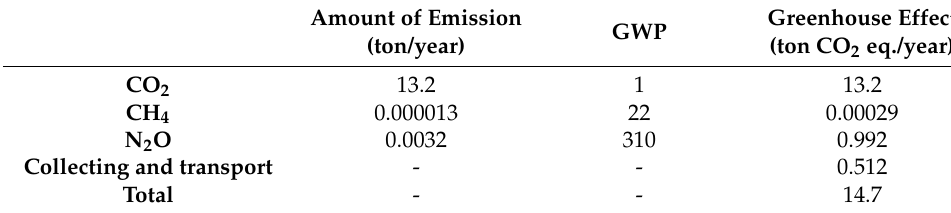
Table 16. The total amount of GHG emission in the DSH-MSW scenario.